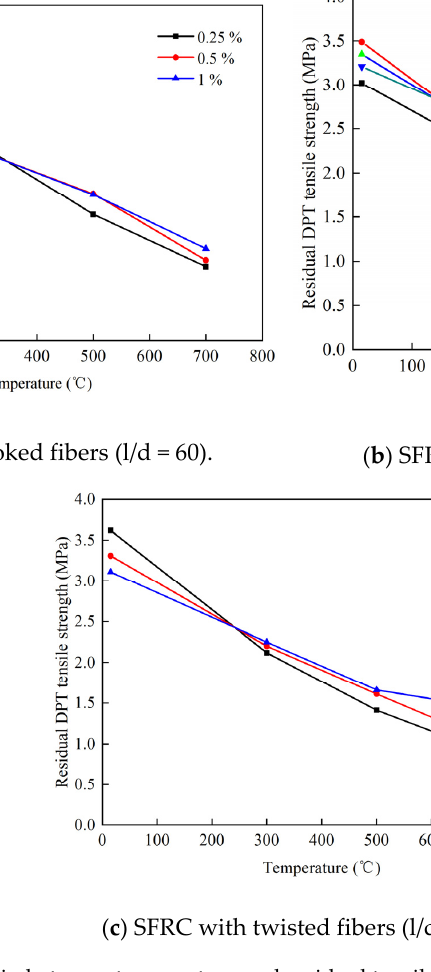
Figure 5. Relationship between temperature and residual tensile strength of the three specimens [63].